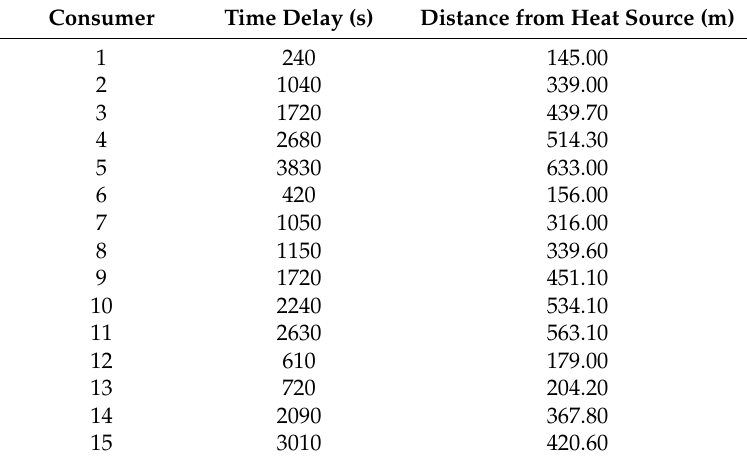
Table 3. The delay time of the heat consumer.